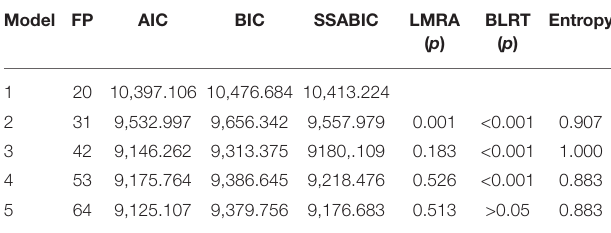
TABLE 1 | Description of symptoms in the questionnaire of DSSS. TABLE 2 | Fit indices of latent profile models of DSSS somatic symptom